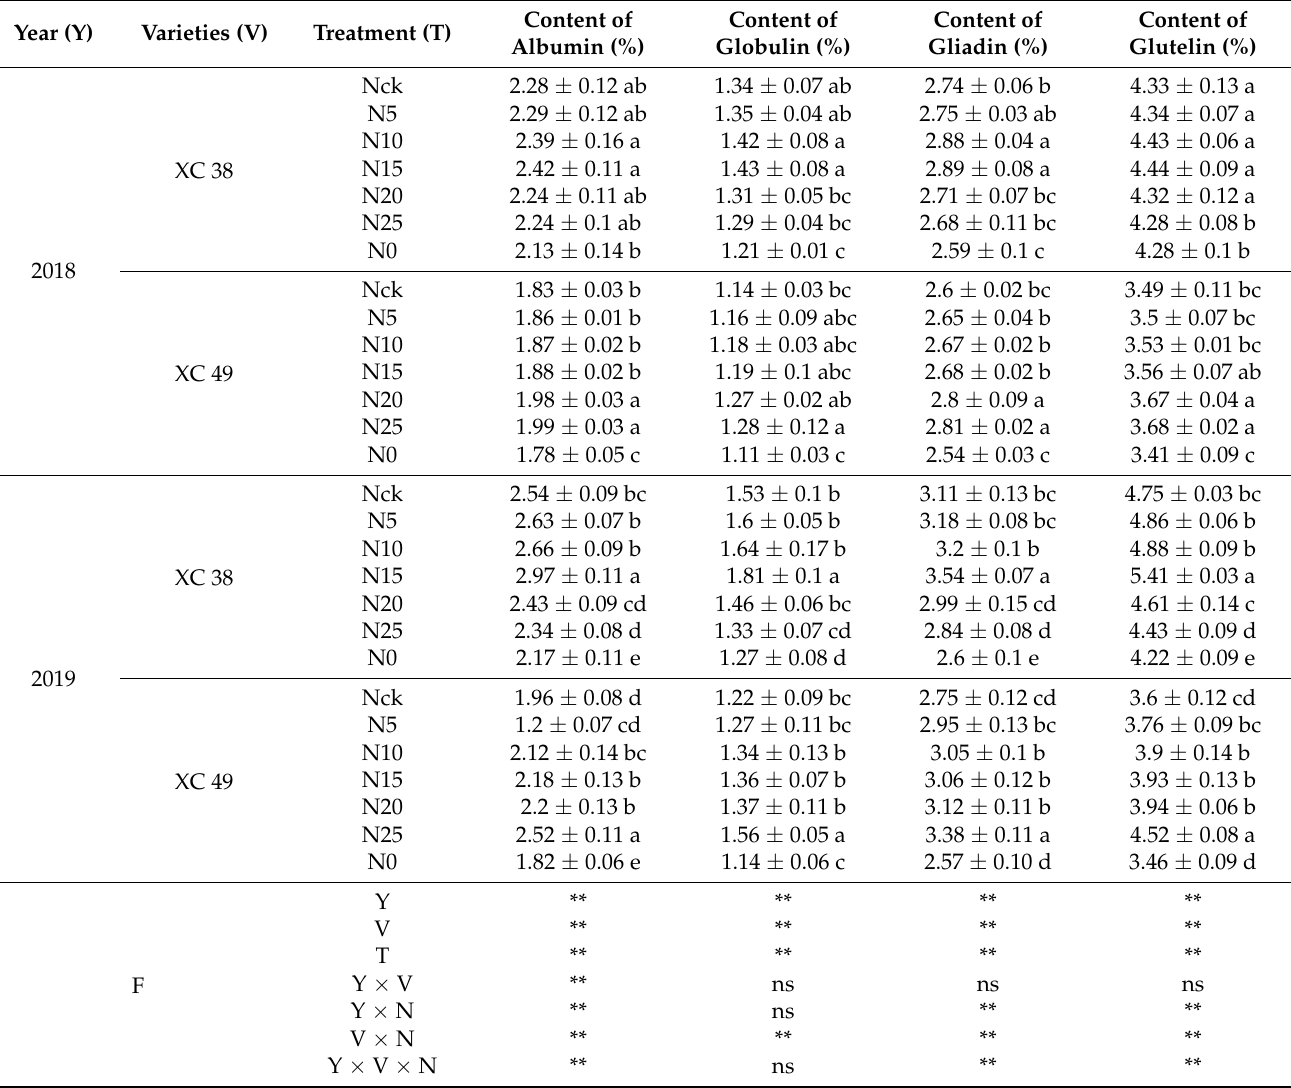
Table 3. Averages of protein components in 2018 and